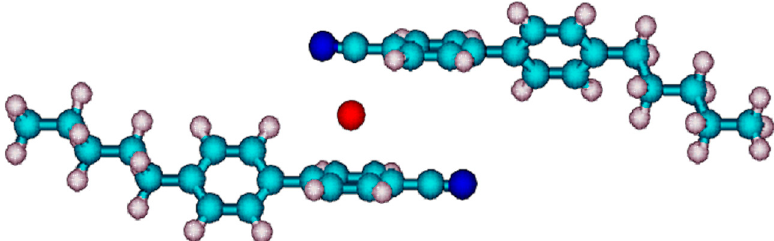
Figure 1. The scheme of a 4-cyano-4 ′ -pentylbiphenyl (5CB) bi-ligand molecular complex Ag(5CB) 2.